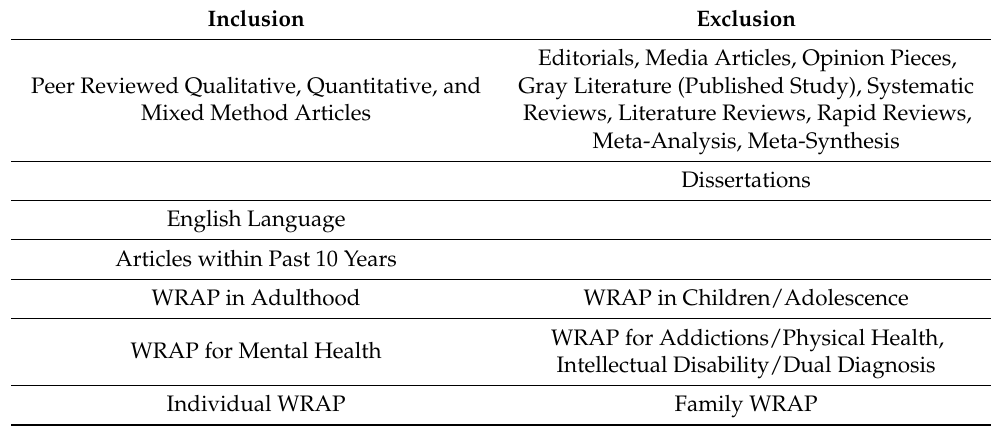
Table 1. Inclusion/exclusion